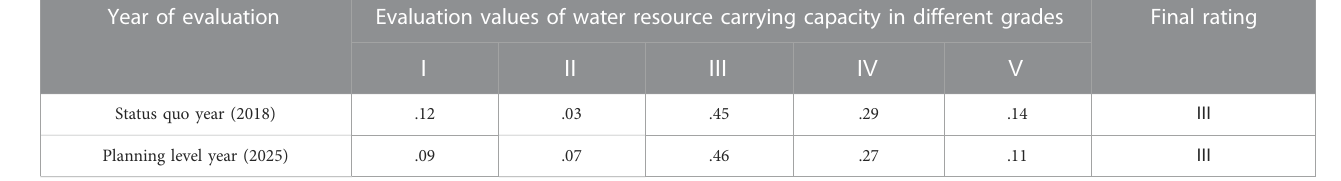
TABLE 13 Evaluation results of cloud model of water resource carrying capacity game. Year of evaluation Evaluation values of water resource carrying capacity in different